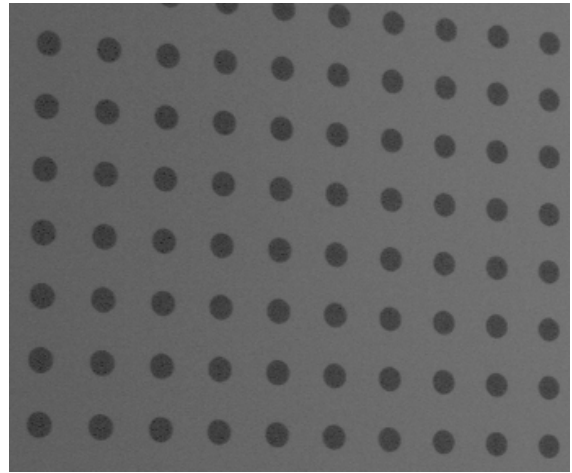
Figure 8. Target’s image captured by the CCD.